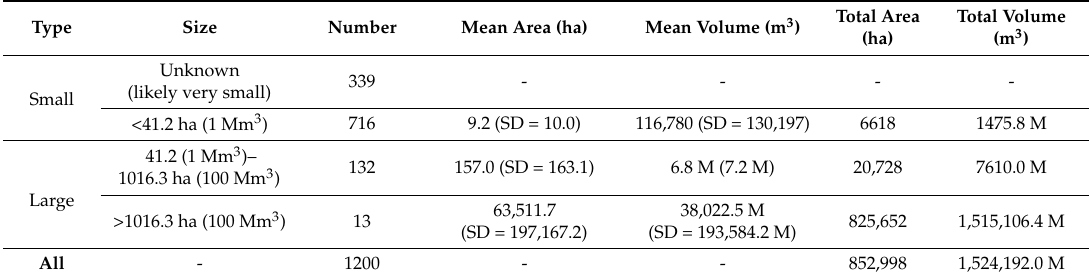
Table 3. Reservoir number and size based on their maximum GSW-derived extents, providing an indication of reservoir capacity and an upper limit for current reservoir size. Volumes are calculated using Equation